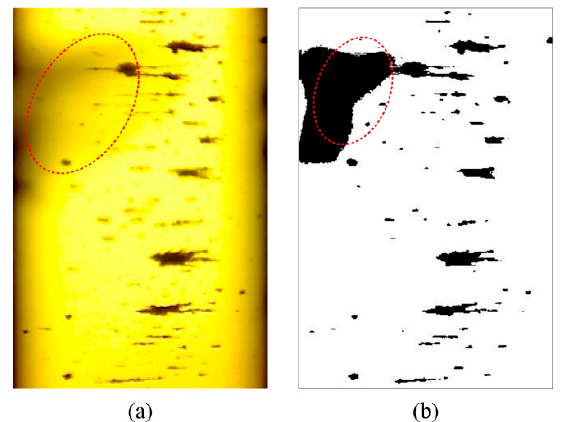
Figure 1. Effect of interference shadows on the binarization of on-line visual ferrograph (OLVF) ferrograms (shadow is encircled in red): ( a ) OLVF ferrogram; ( b ) results obtained by Otsu method.